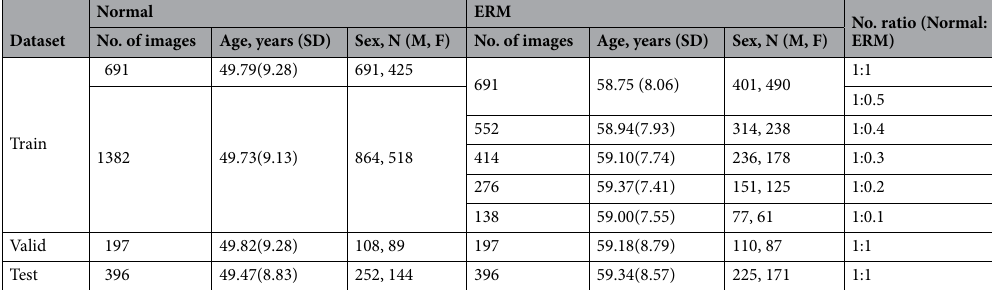
Table 1. Baseline characteristics of study for evaluating classification performance.